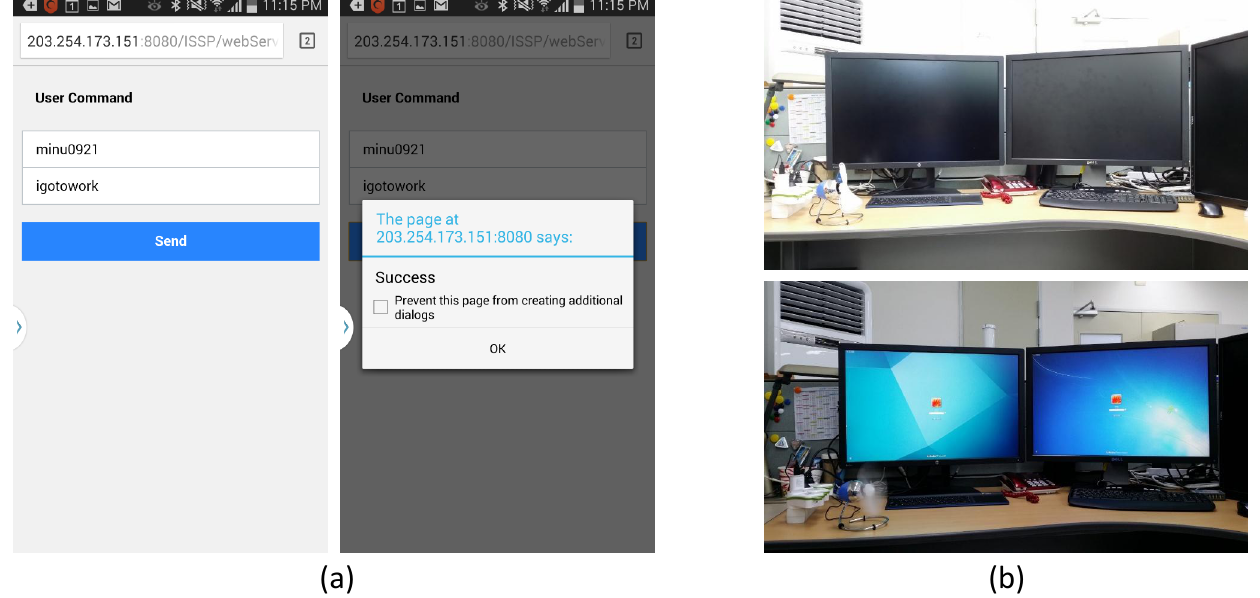
Figure 14. Results of ( a ) the web app operation (operation mode) and ( b ) IoT device control